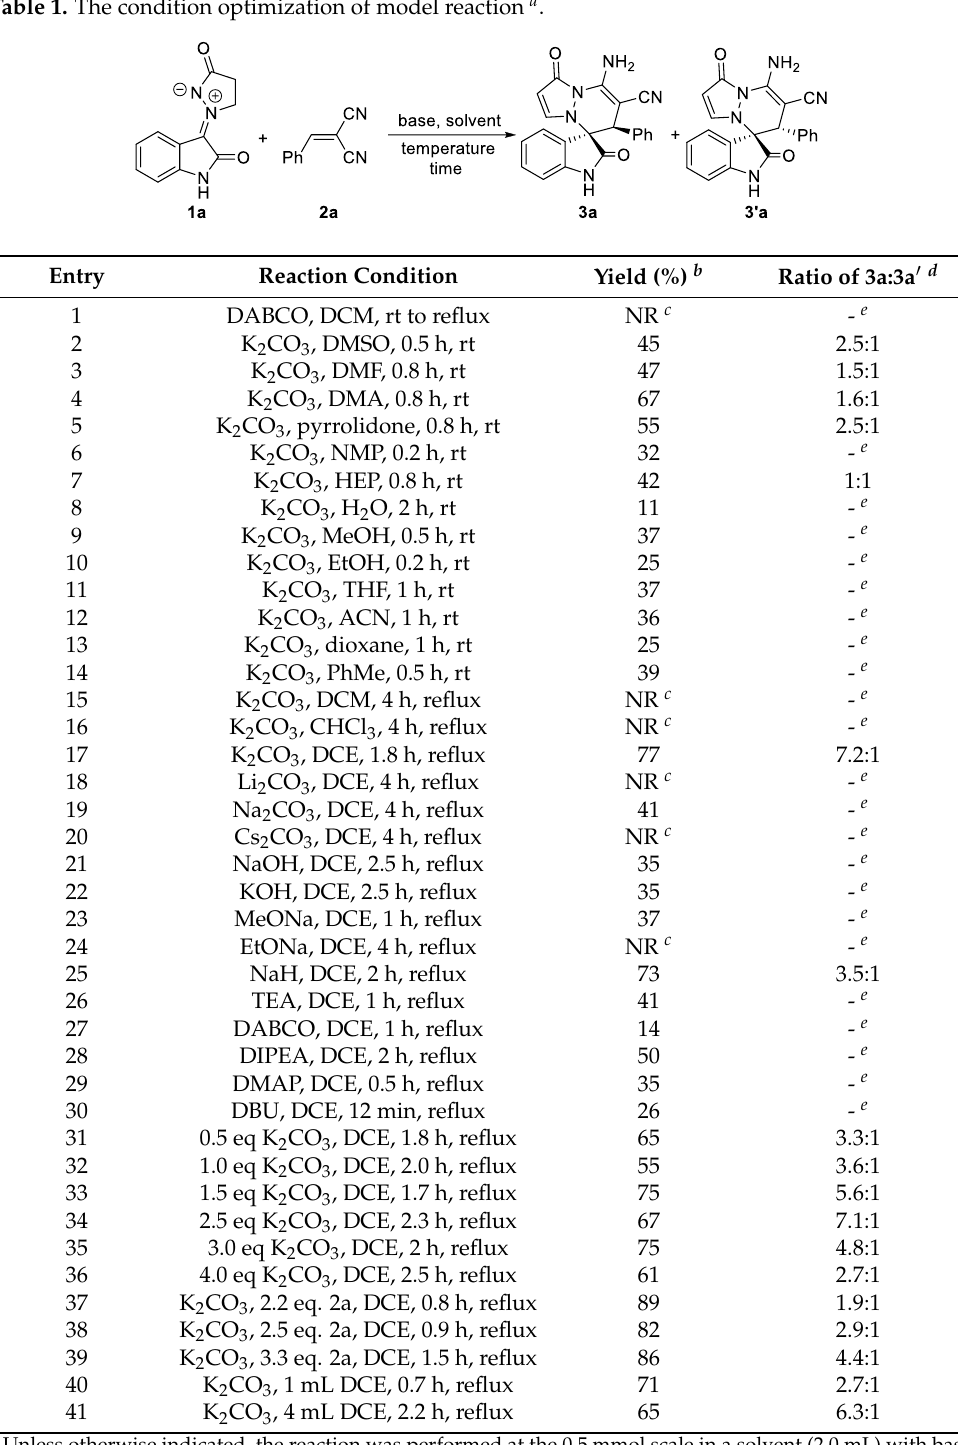
Table 1. The condition optimization of model reaction a .